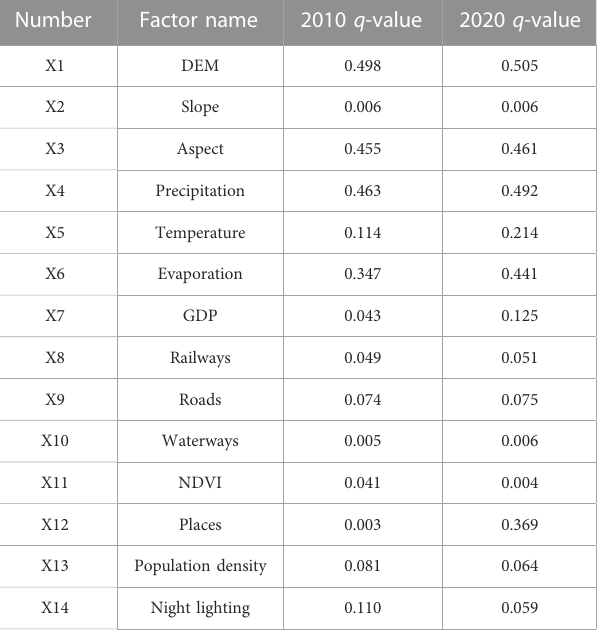
TABLE 5 Results of the variance and factor detector of habitat quality in Anhui